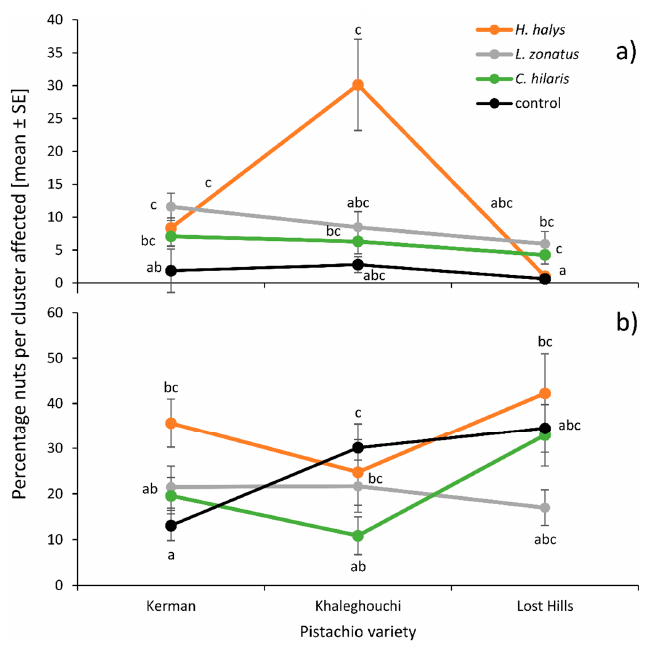
Figure 3. Interaction between insect treatment and pistachio variety for ( a ) epicarp lesions immediately after insect exposure ‘el exp’ and ( b ) epicarp lesions during harvest time ‘el harv’. Different letters indicate significant differences (GLMM, Tukey-adjusted mean